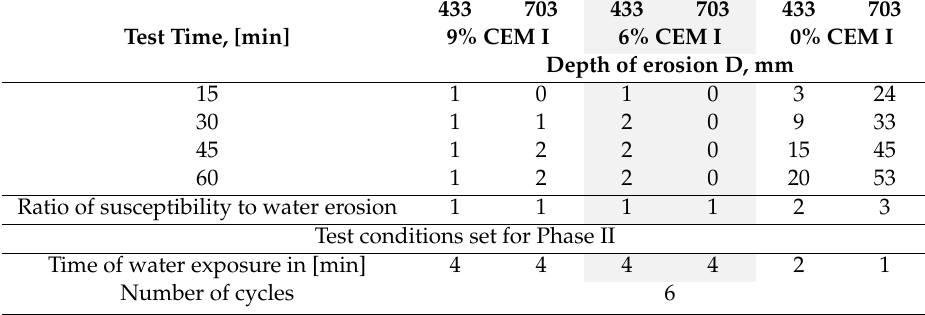
Figure 7. Sample surfaces after the completion of the first stage of the resistance test for water erosion. Table 6. Summary of the results of the erosion survey in Phase I and the assumptions of Phase II.